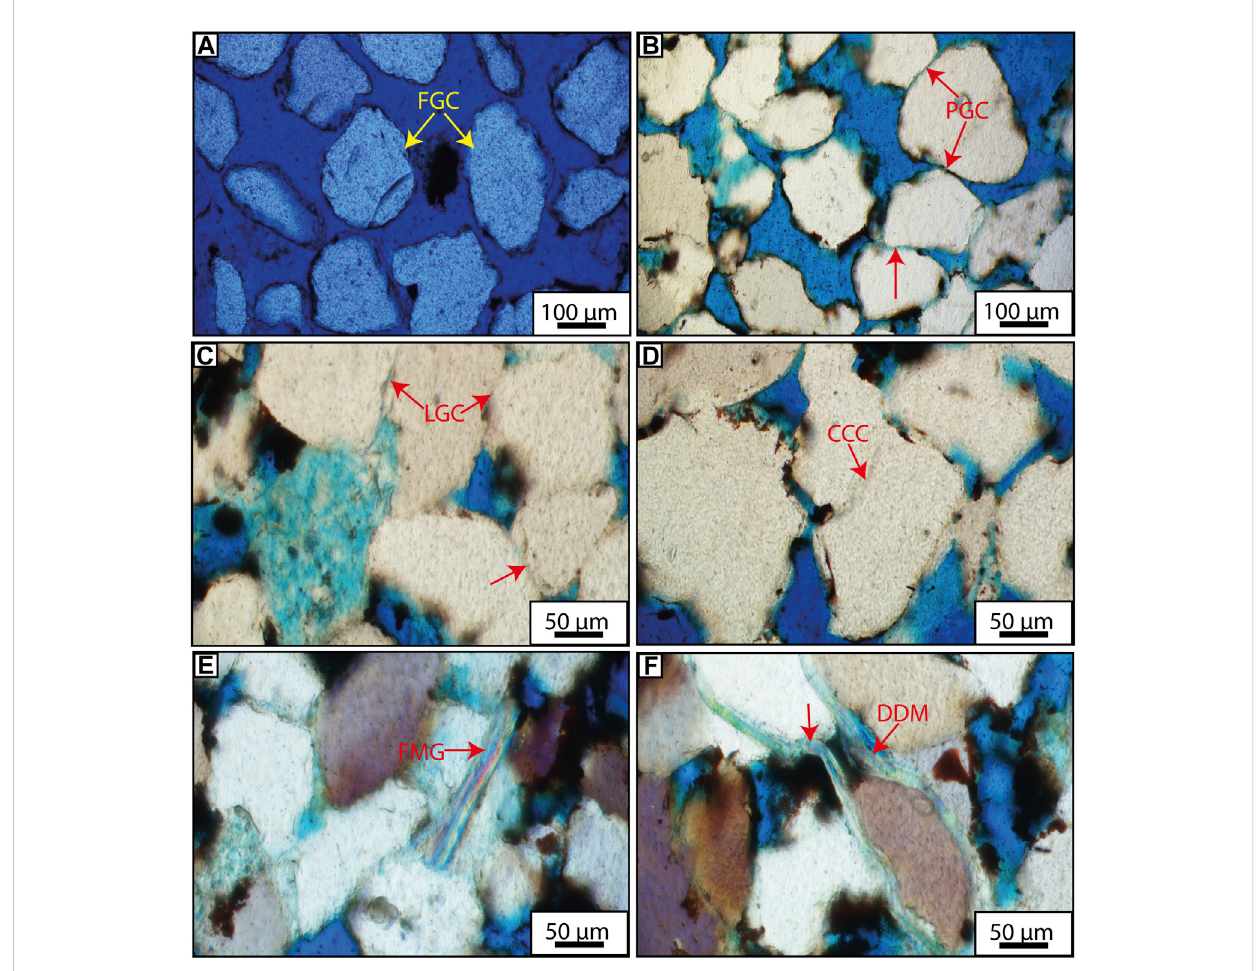
FIGURE 7 Thin-section photomicrographs indicating the extent of mechanical compacation in the studied sandstones. (A) Floating grain contact (FGC). (B) Point graincontact(PGC). (C) Long graincontact (LGC). (D) Concavo-convex contact (CCC). (E) Flat micagrain(FGC). (F)